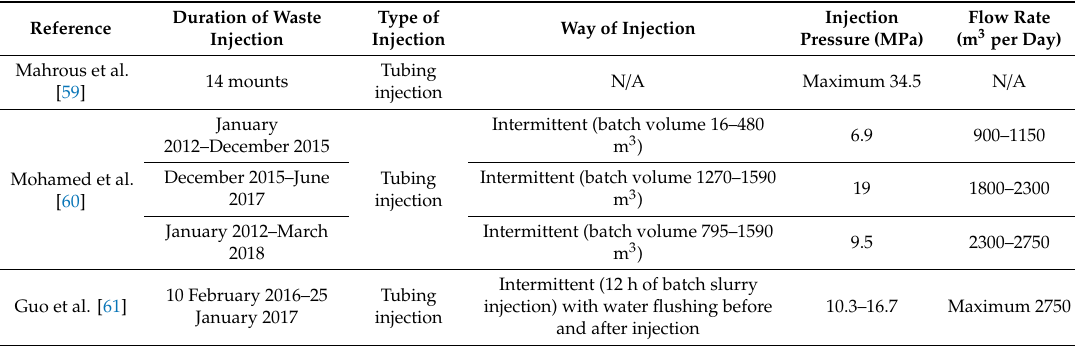
Table 4. Waste slurry injection parameters used in di ff erent injection